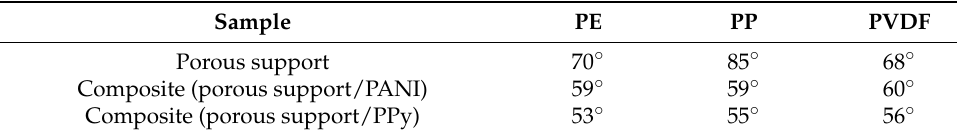
Table 4. Contact angle ( θ ) of the porous supports and the composites.